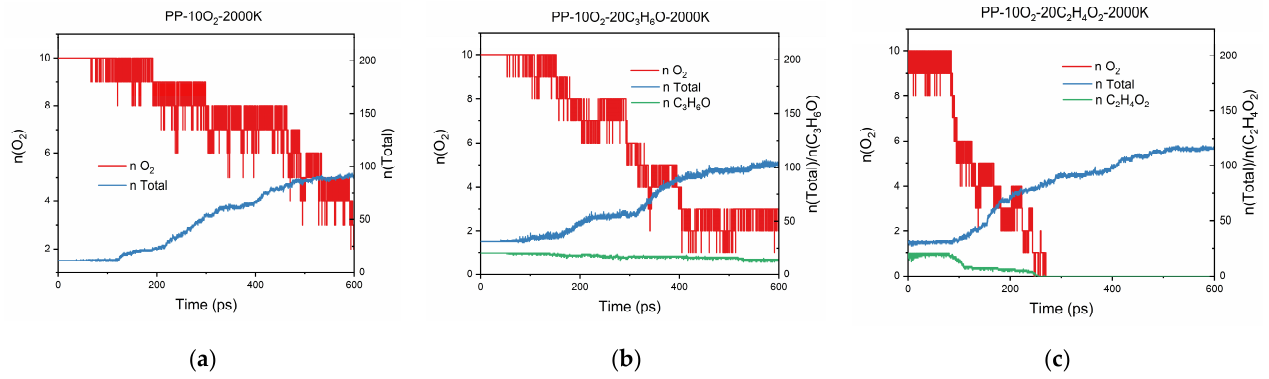
Figure 7. Evolution of the total number of molecular fragments and the number of oxygen molecules as a function of time: